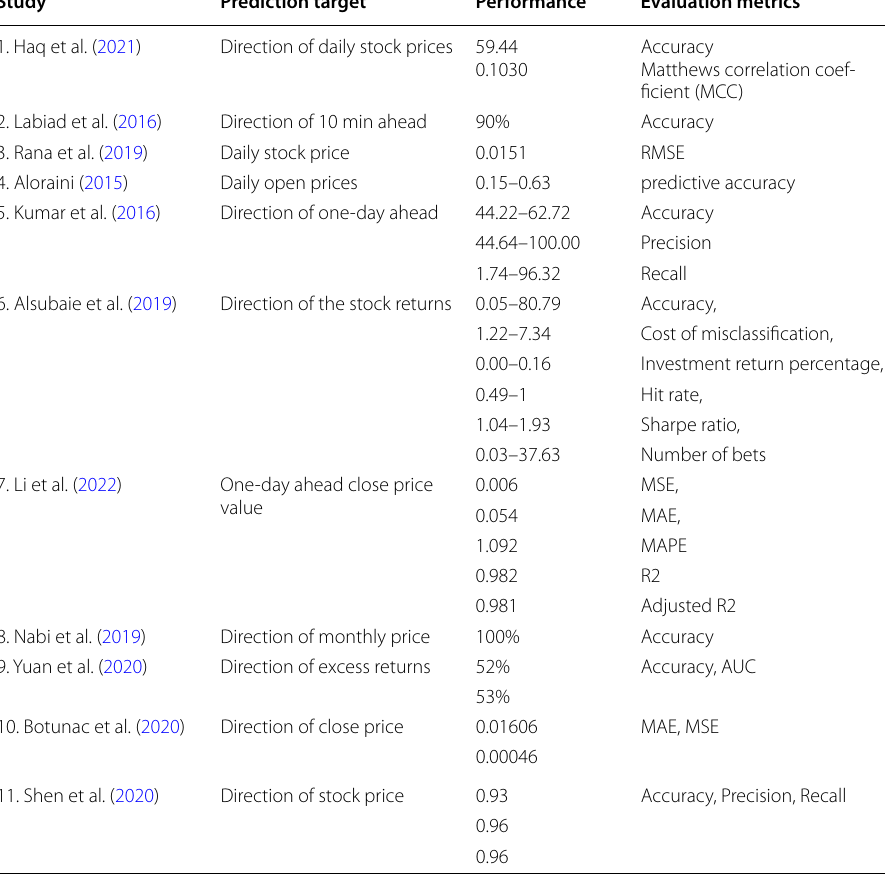
Table 2 Performance comparison based on target predictions, performance, and evaluation